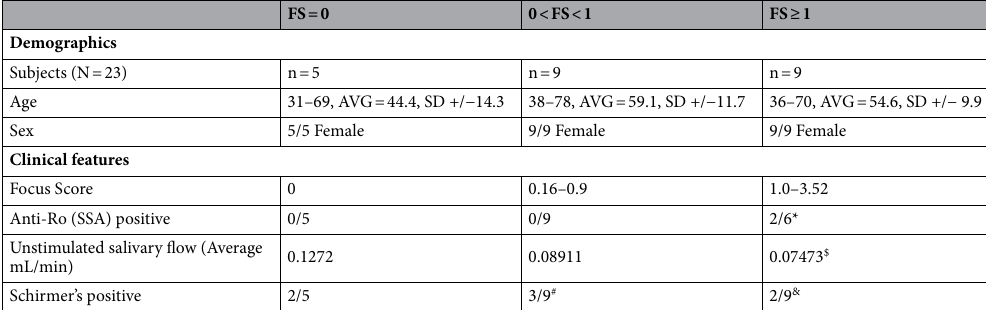
tion for patient groups (i.e., non-pSS (FS = 0), non-pSS (0 < FS < 1), and pSS (FS ≥ 1)) is presented in Table 1. The entire study and all associated experimental procedures were approved by the Atrium Health Institutional Review Board (Charlotte, NC, USA). All experiments were performed in accordance with the Helsinki declara- tion and following all relevant guidelines and regulatory practices. After obtaining informed consent for each